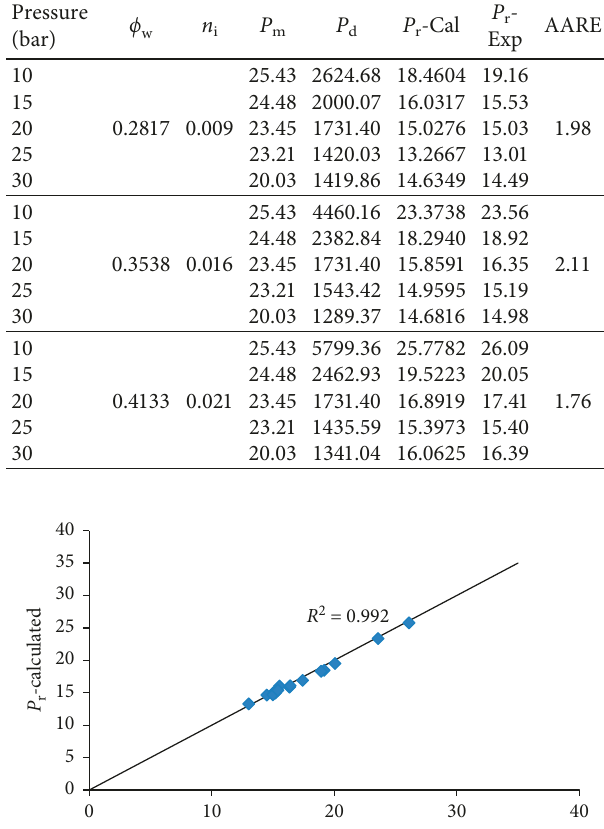
Table 7: P r -calculated and P r -experimental for CO 2 of IL3M-emim [Tf 2 N] using the modified MWS model.